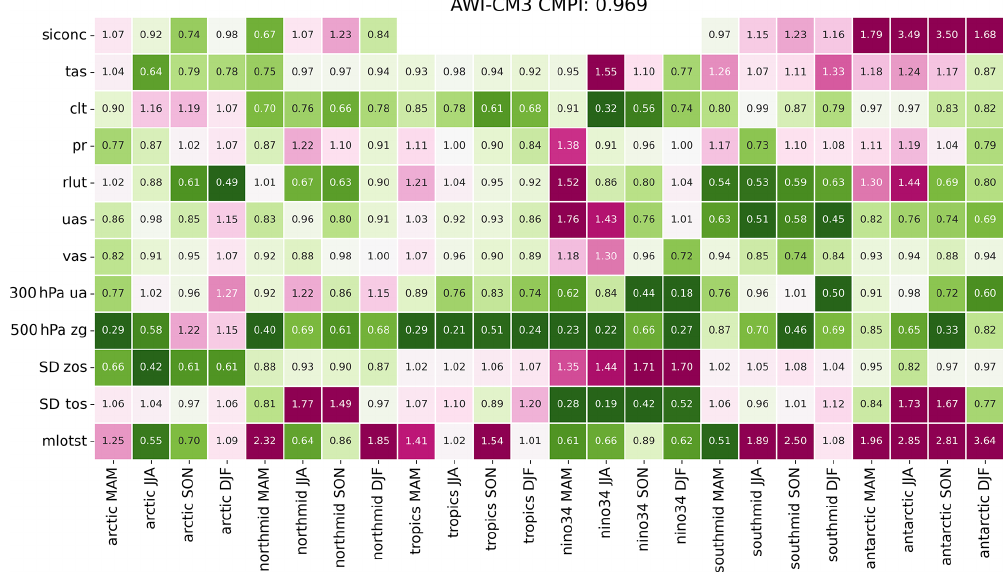
Table B1. HIST biases as in Table 1 but using NCEP/DOE Reanalysis II by Kistler et al. (2001) instead of ERA5 for near-surface air